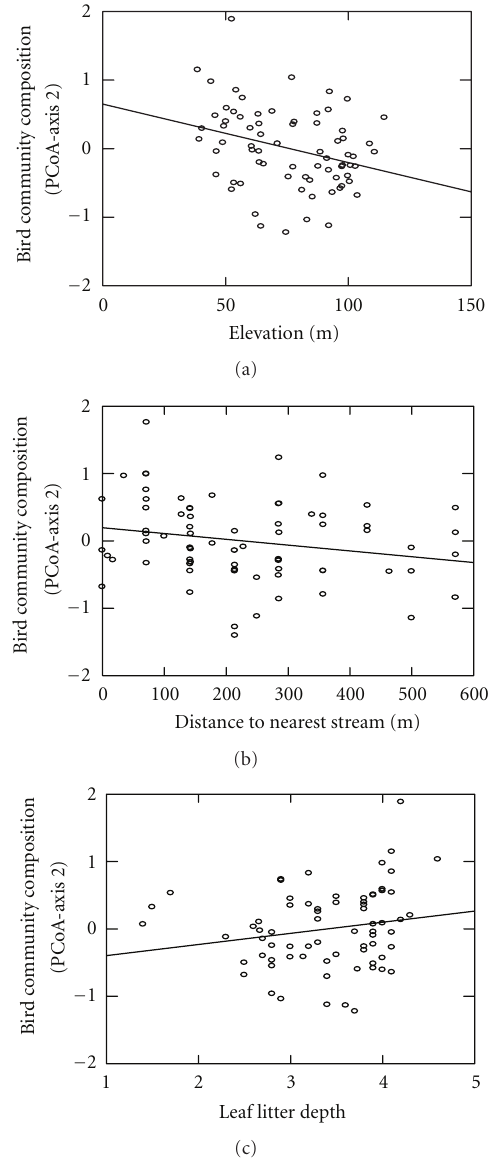
Figure 4: (a) The influence of terrain inclination (elevation), (b) stream proximity, and (c) depth of forest floor leaf litter on bird community composition in the Reserva Florestal Adolpho Ducke, Manaus, Brazil. Qualitative data (species presence/absence for the 72 transects with mist-nets), which were subjected to ordination analyses (PCoA). Only the second PCoA-axes were used to con- struct the graphs, the ones showing statistical